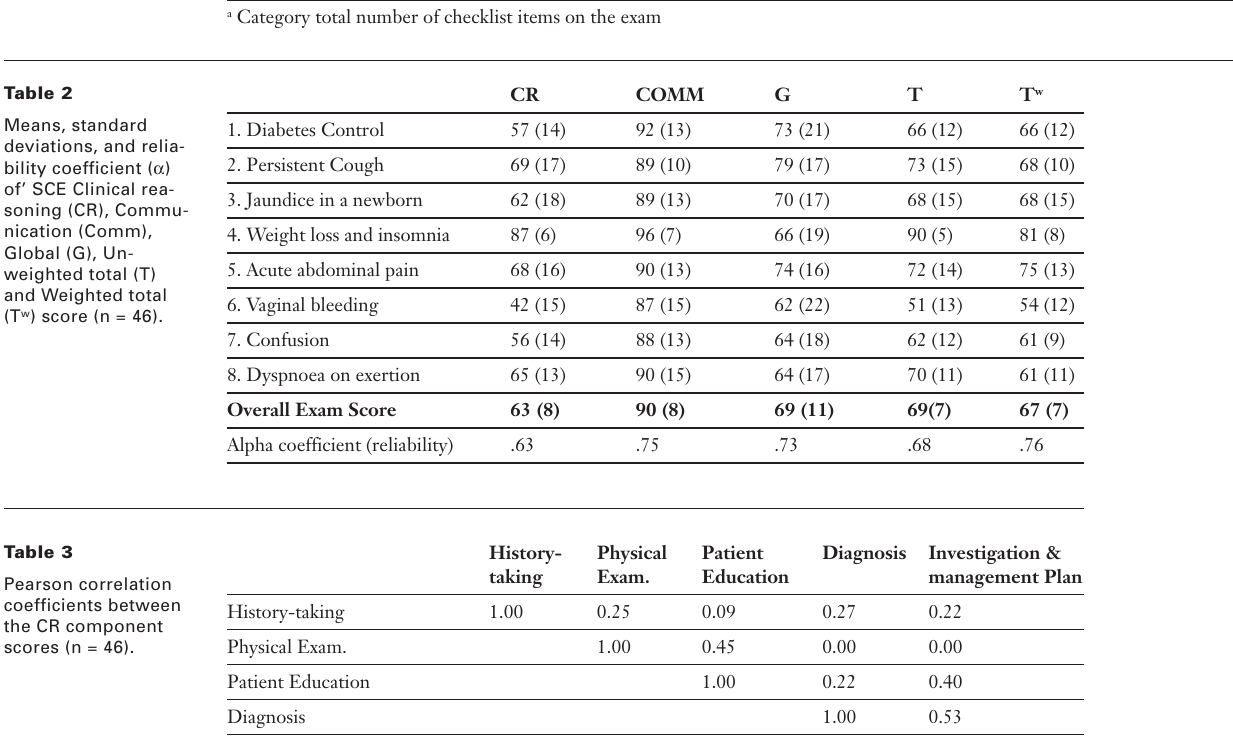
Table 1 Means and standard deviations of candi- dates’ (n = 46) SCE Clinical reasoning (CR) and CR compo- nent percentages scores on History, Physical examina- tion, Patient educa- tion, Diagnosis, and Investigation & man- agement.